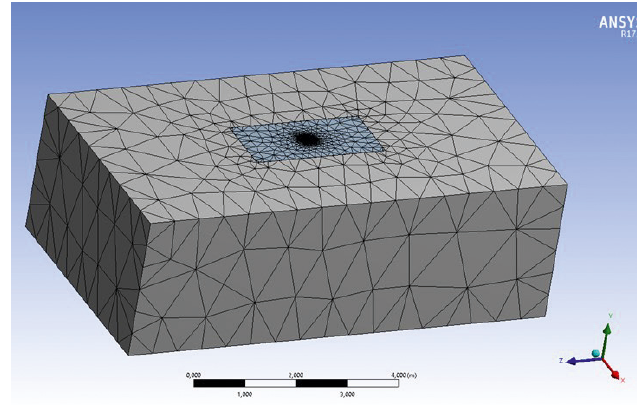
Figure 3. Complete FE model with slab loaded in the